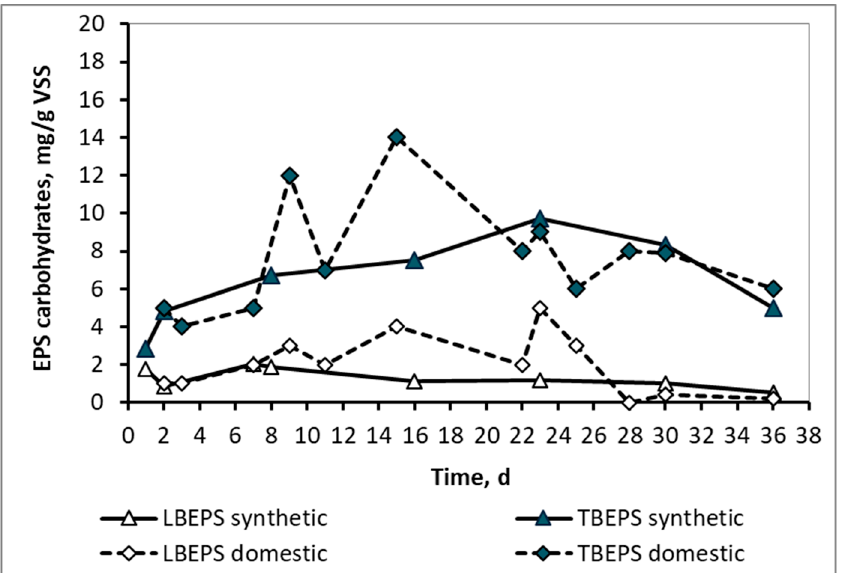
Figure 6. LBEPS and TBEPS concentrations in the form of carbohydrates for the mixed liquor of synthetic and domestic wastewater.